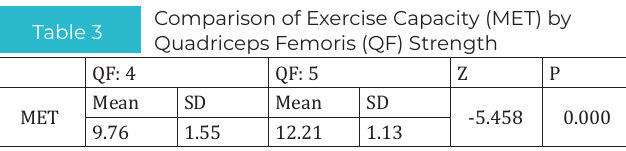
MET-Metabolic Equivalent; SD-Standard Deviation; QF-Quadriceps